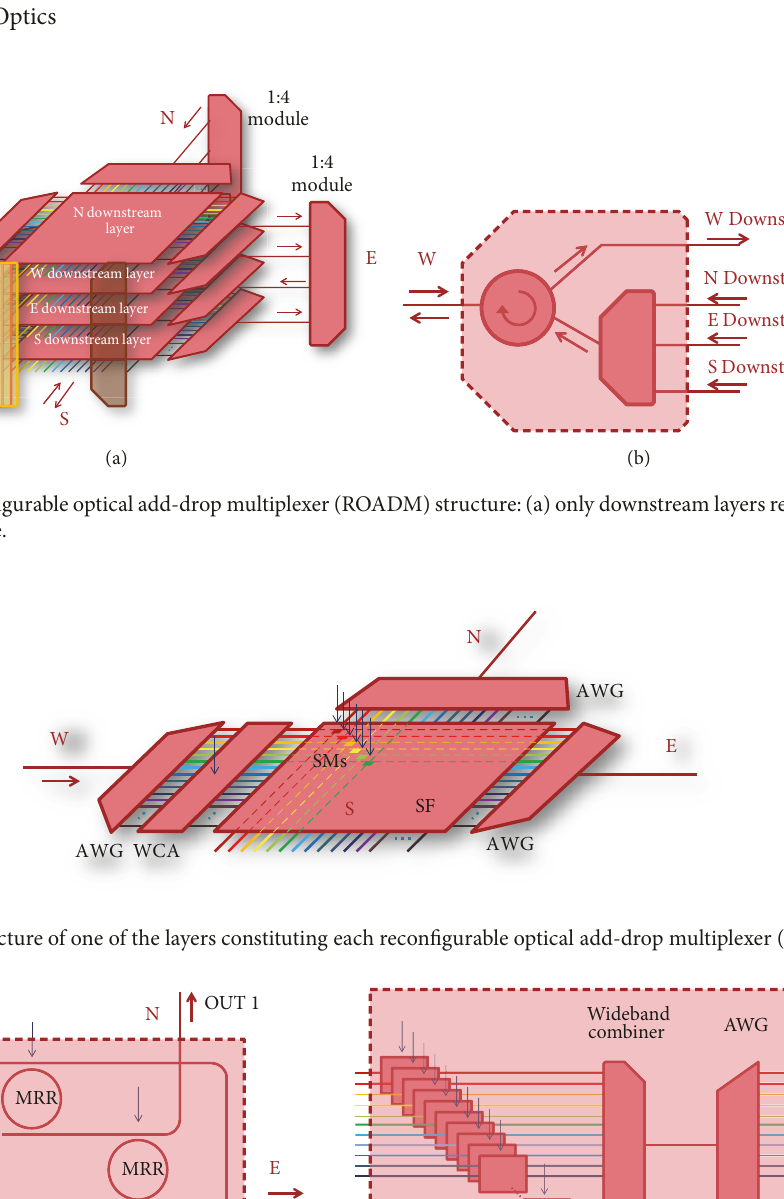
(TAOWCs), a wideband coupler and an AWG used to reorder the wavelength channels in input to the